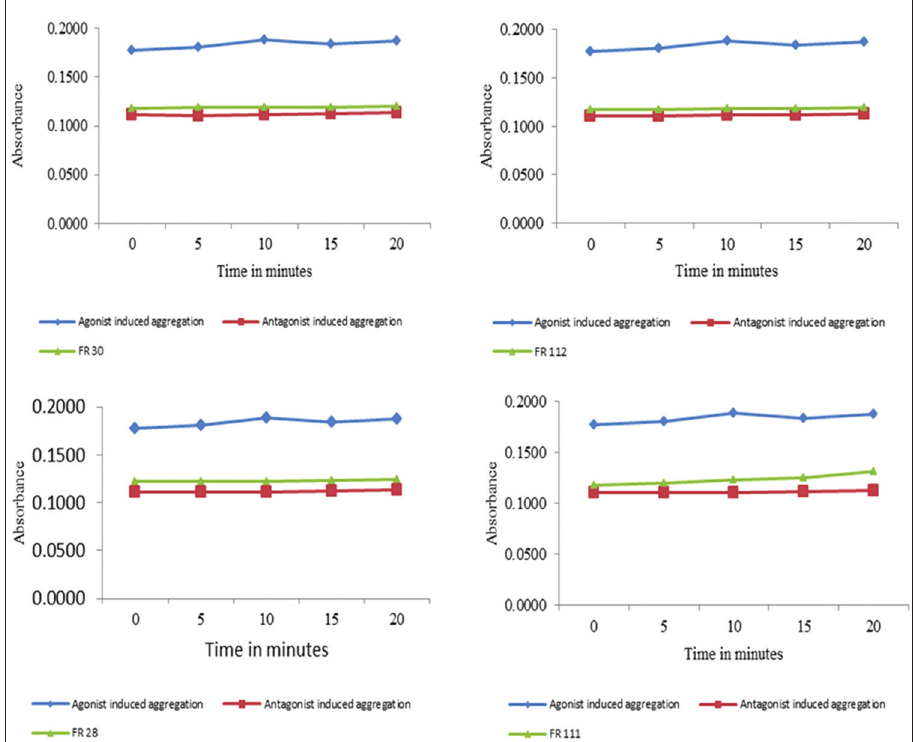
Figure-4: Activity of Hyalomma anatolicum salivary gland individual protein fractions on bovine platelet aggregation inhibition after stimulation with thrombin (0.5